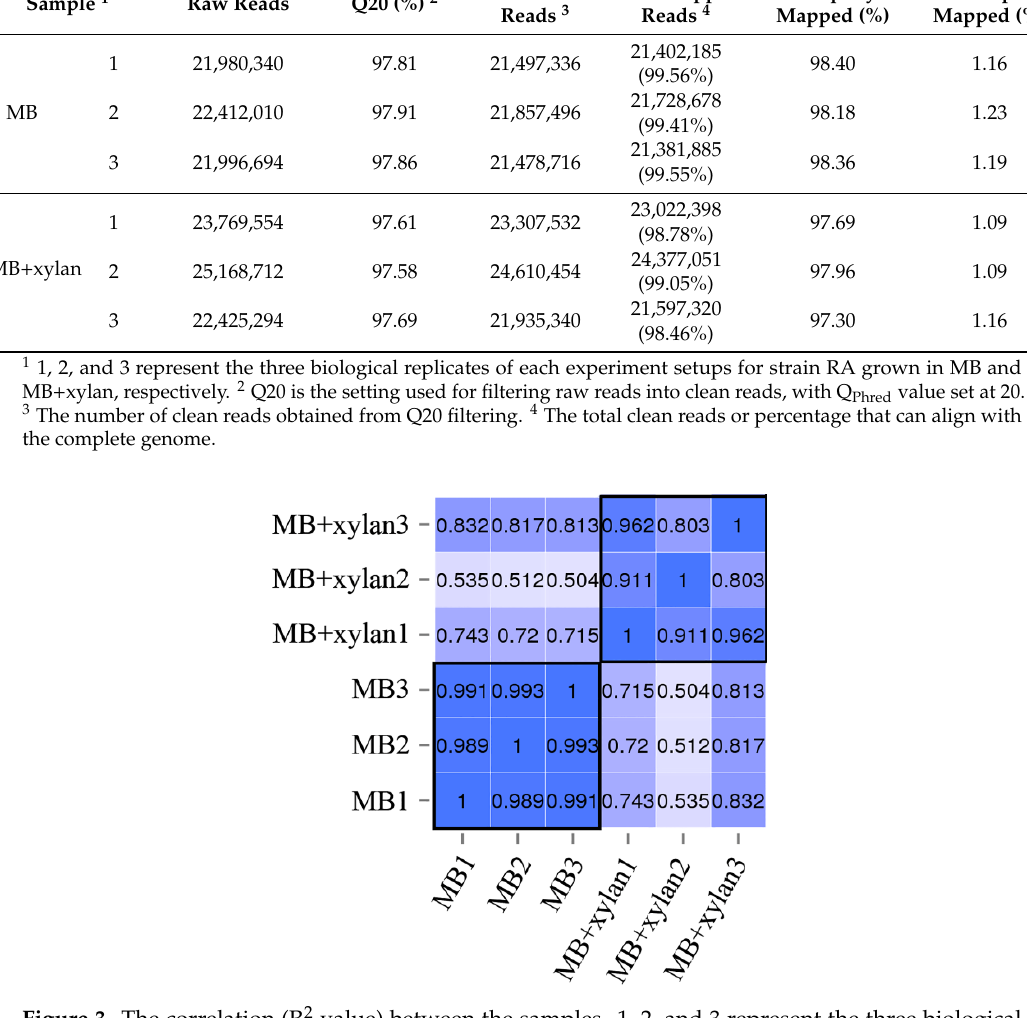
Figure 3. The correlation (R 2 value) between the samples. 1, 2, and 3 represent the three biological replicates of each experiment. MB: R. sacchariphilus strain RA culturing on MB medium. MB + xylan: Bacteria growth on MB supplemented with beechwood xylan (0.1% w/v ).